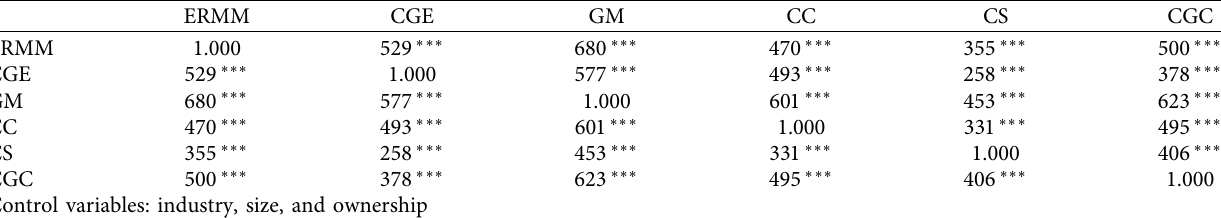
Table 5: Partial correlation coefficient matrix of variables in the extended model of the enterprise risk management maturity